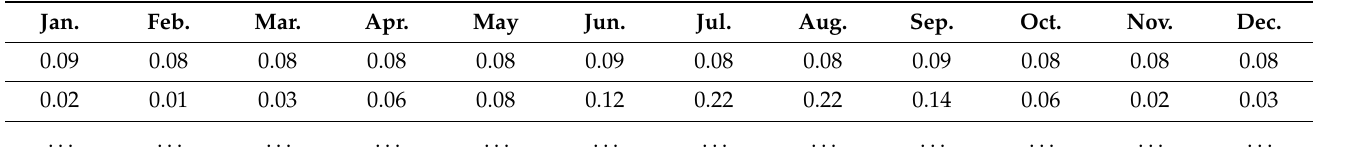
Table 2. Examples of P_month